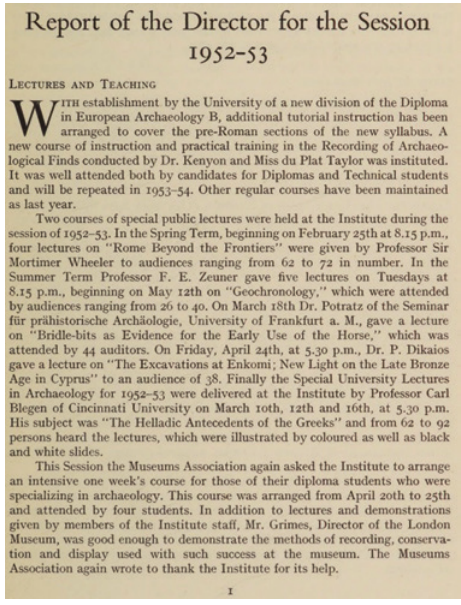
Figure 4 The Director’s Report from 1952–3, Annual Report of the Institute of Archaeology 10, provides details of the international connections of the